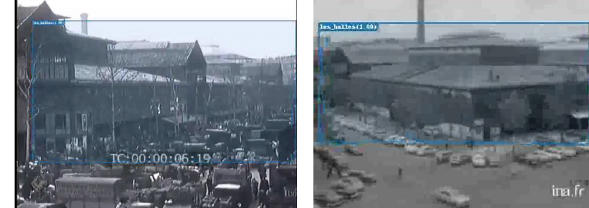
Figure 7. Example of frames with Les Halles correctly detected in the film footage.